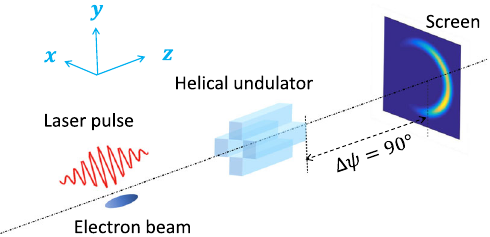
.FIG. 1. Illustration of the optical circular deflector (not to